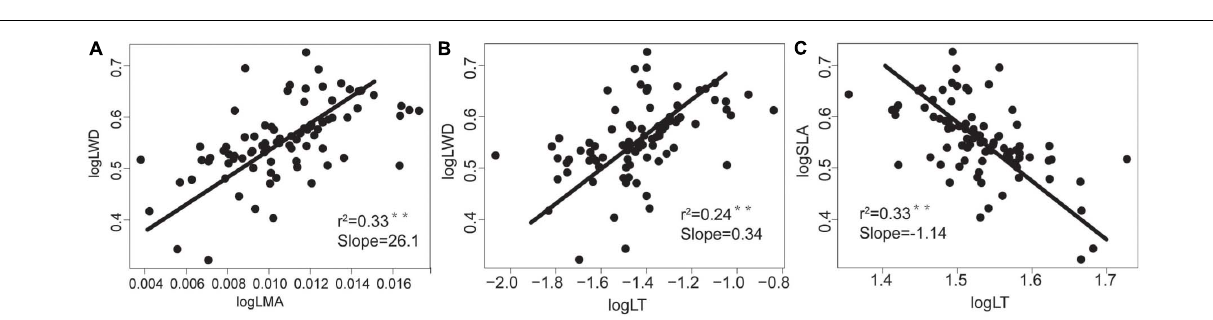
FIGURE 3 | The relationships between morphological traits of tree species’ aboveground and underground organs in the tropical cloud forest. The slope values and P -values for (A) WD-LMA, (B) WD-LT and (C) SLA-LT derived from SMA analyses. * and ** indicate significant correlations at the levels of P < 0.05 and P < 0.01,